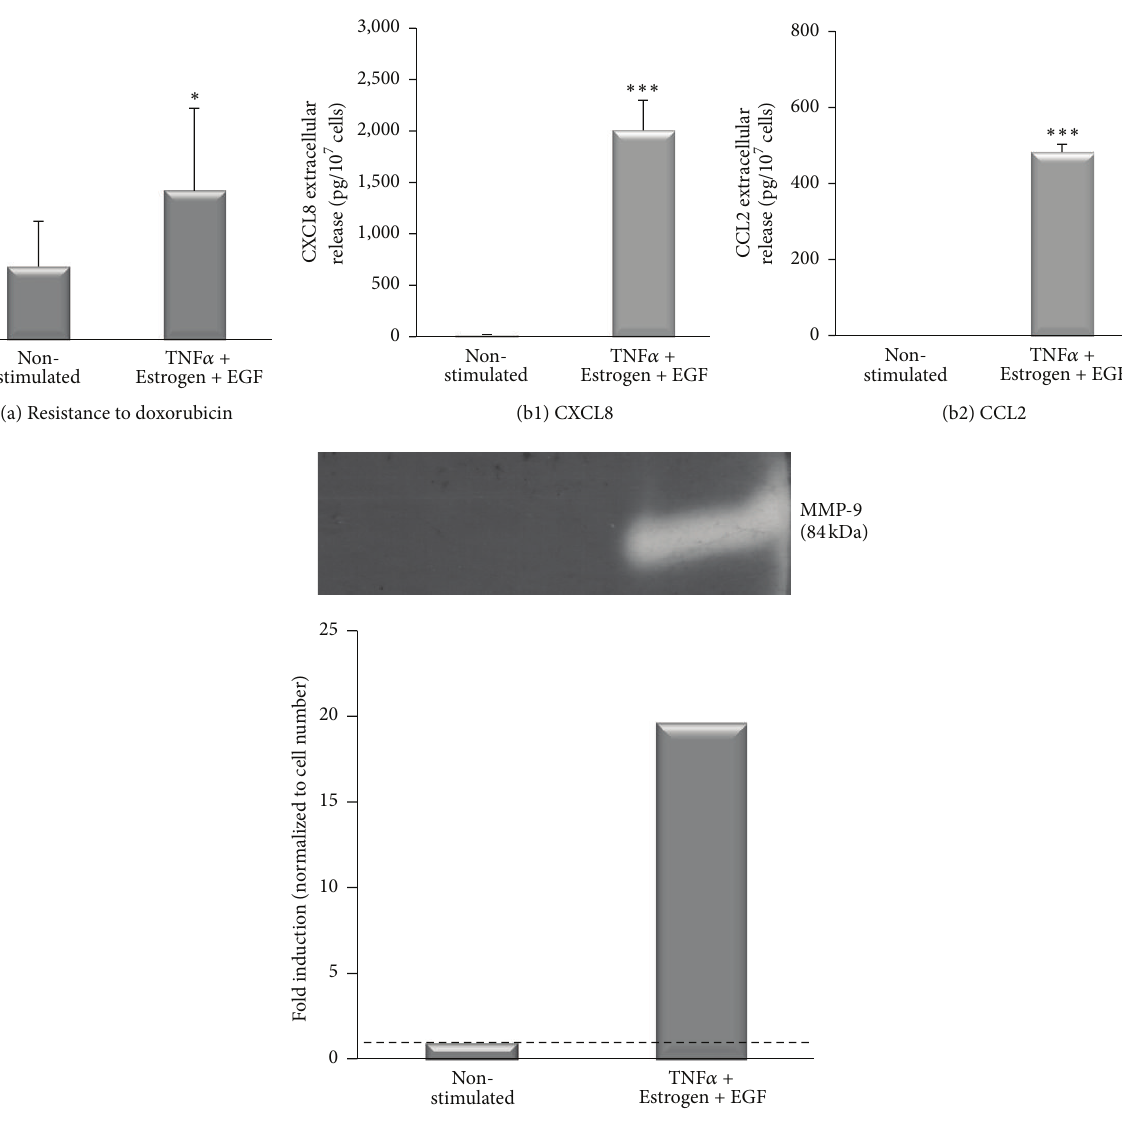
Figure 8: In response to combined stimulation by TNF 𝛼 + Estrogen + EGF, breast tumor cells acquire functional promalignancy properties. Breast tumor cells were stimulated by TNF 𝛼 + Estrogen + EGF (concentrations as in Figure 1) for three days. Non-stimulated: cells grown with the diluents of the above factors. (a) Resistance to doxorubicin. Following their stimulation with the above-mentioned factors, the cells were replated with the aforementioned stimulation in the presence or absence of 1 𝜇 M doxorubicin for additional three days. Cell viability was determined by XTT assay. ∗ 𝑃 < 0.05 for the difference between stimulated and non-stimulated cells. The results are from a representative experiment of 𝑛 ≥ 3 . (b) Release of promalignancy factors by the tumor cells, calculated per cell number. The expression of CXCL8 (b1) and CCL2 (b2) was determined in the CM of the cells by ELISA, at the linear range of absorbance. ∗∗∗ 𝑃 < 0.001 for the differences between stimulated and non-stimulated cells. The results are from a representative experiment of 𝑛 = 3 . (c) Release of functional MMPs, determined by zymography assays performed on cell CM. The bar graph shows the quantitative expression of MMPs, calculated per cell number. The results are from a representative experiment of 𝑛 ≥ 3